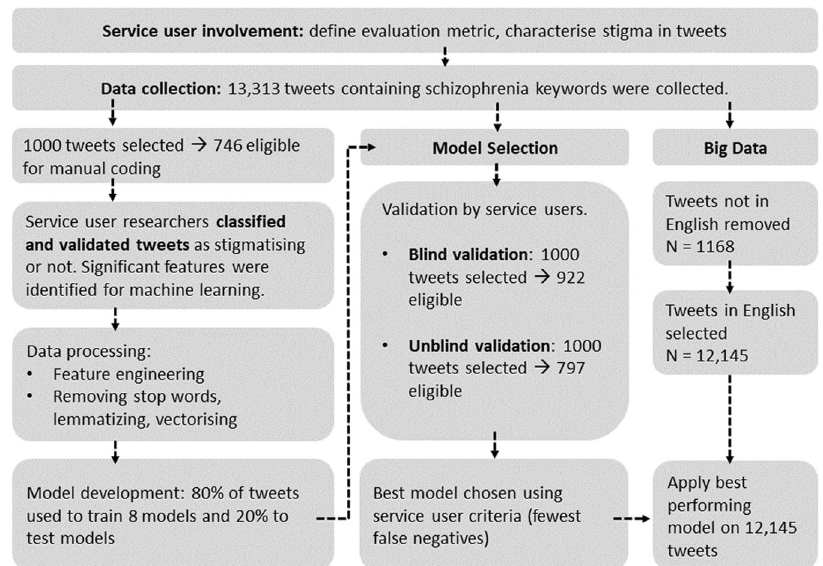
Fig. 1 An overview of our methodology and data collection. An outline of the number of tweets used for each section of the methodology and how they were